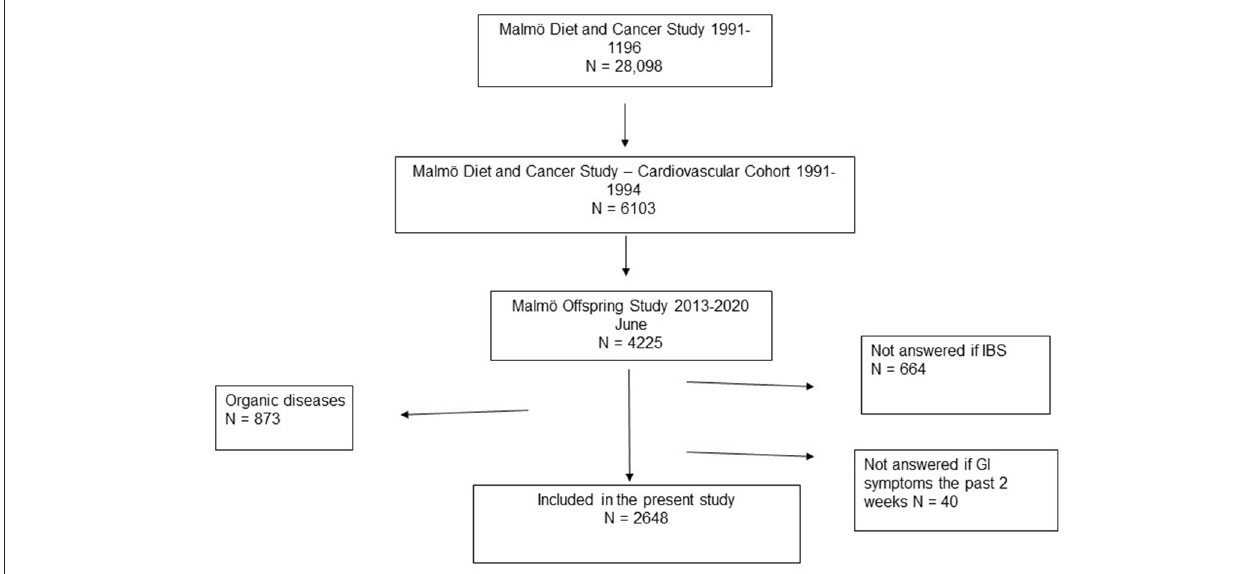
FIGURE 1 | The diagram shows the origin of the participants. Malmö Diet and Cancer Study invited everyone living in Malmö between 1991 and 1996 and were born between 1923 and 1950. A total of 28,098 patients completed all tests. A subcategory, the cardiovascular cohort, was extracted from those participants, containing a total of 6,103 randomly selected patients who participated between the years 1991 and 1994. Malmö Offspring Study (MOS) was a population-based cohort consisting of children and grandchildren to someone who was included in the MDC-CC. This study cohort included those from MOS who had answered the following two questions: “Do you several times a month suffer from abdominal pain and irregular bowel habits known as IBS?” and “Have you experienced bowel symptoms during the past 2 weeks?” Participants with any organic gastrointestinal diseases (celiac disease, Crohn’s disease, ulcerative colitis, lactose intolerance, reflux, and ulcer) were